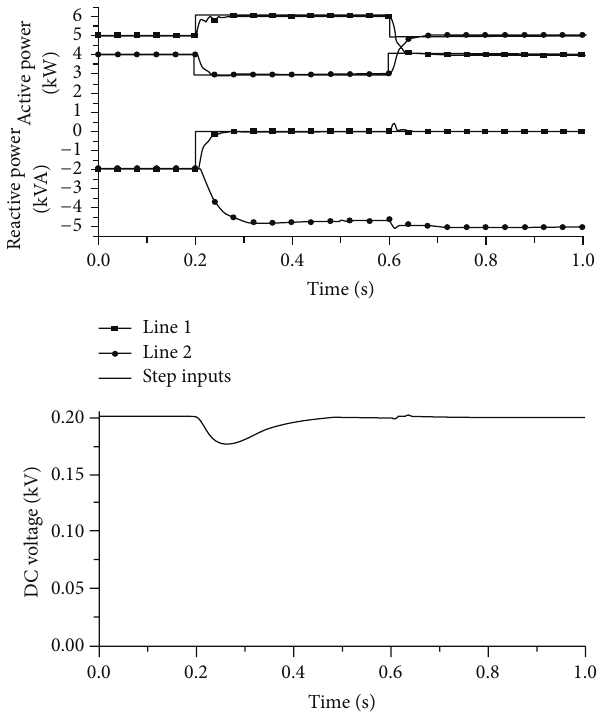
Figure 15: Simulation results of various transmission parameters (double line).